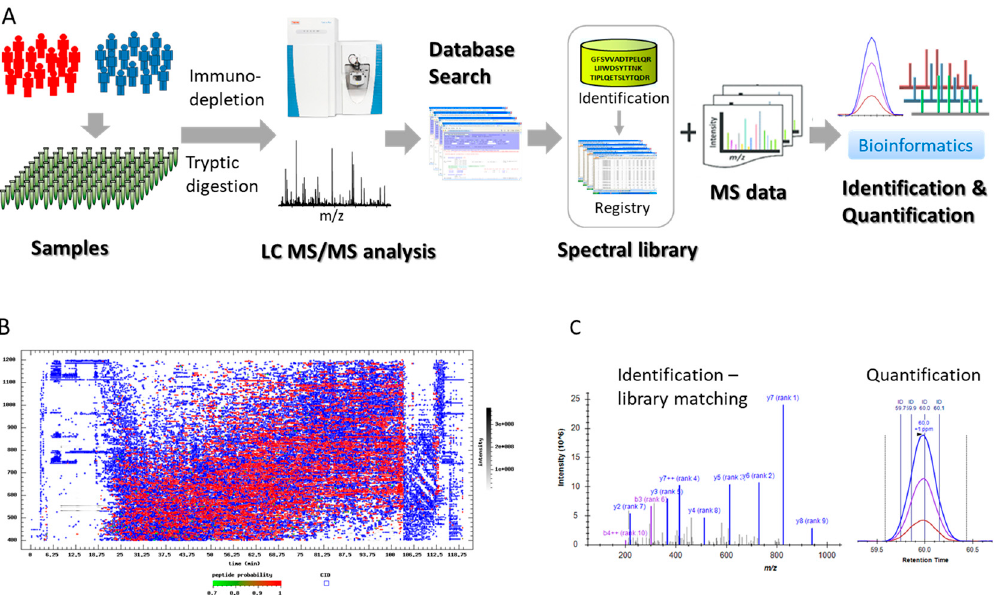
Figure 1. Illustration of a spectral library-based platform. ( A ) The analytical flow, ( B ) a peptide 3D map of a clinical plasma sample after depletion of the 12 most abundant proteins, ( C ) an illustration of a peptide identification and quantification using a spectral library-based approach.